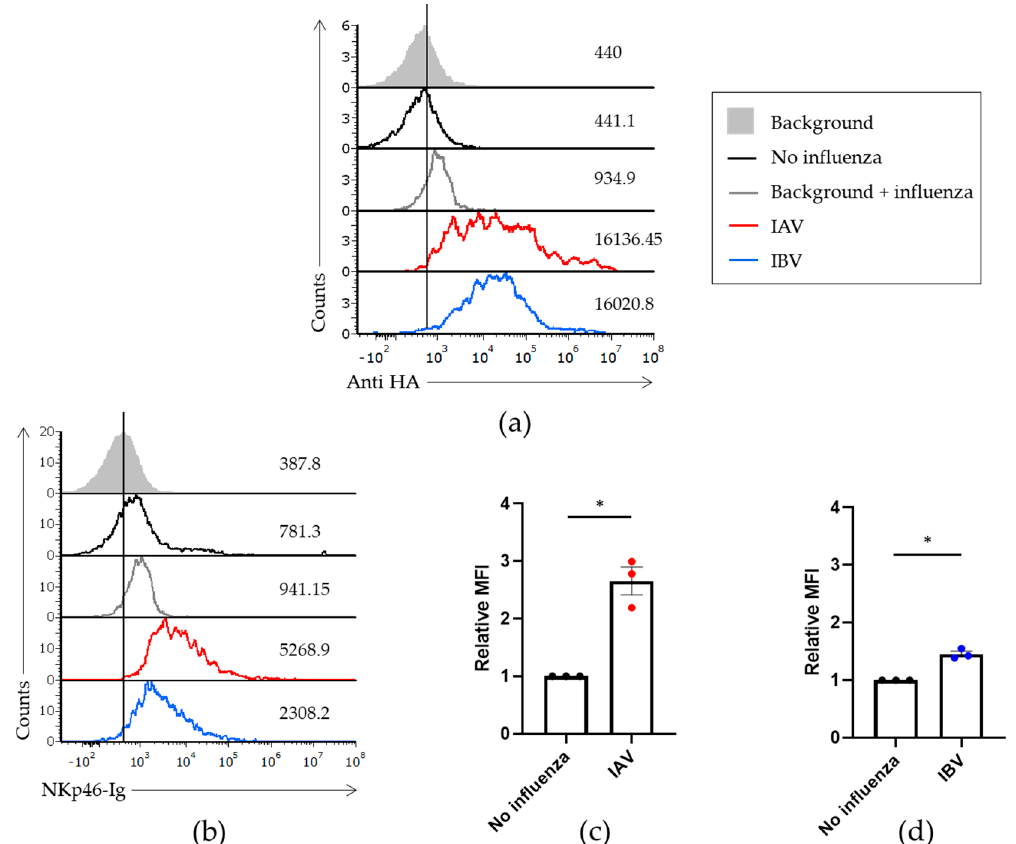
Figure 1. NKp46 binds IAV and IBV. Jeg3 cells were incubated or not (black histogram) with A/Brisbane/59/2007 H1N1 (IAV) or B/Brisbane/60/2008 (IBV). ( a ) FACS staining of IAV (red histogram) and IBV (blue histogram) with antibodies against the hemagglutinin of IAV and IBV, respectively. ( b ) The cells incubated with the indicated viruses were stained with NKp46-Ig fusion protein. The filled histograms and gray, empty histograms represent the staining with secondary antibodies only in the absence or presence of influenza, respectively. Figure shows one representative experiment out of three performed. ( c , d ) MFI quantification of three independent experiments including data presented in ( b ). FACS staining with NKp46-Ig against IAV ( c ) and IBV ( d ) was normalized to the staining of the cells without influenza. Values are shown as mean ± SEM. * p < 0.05 by two-tailed paired Student’s t test.